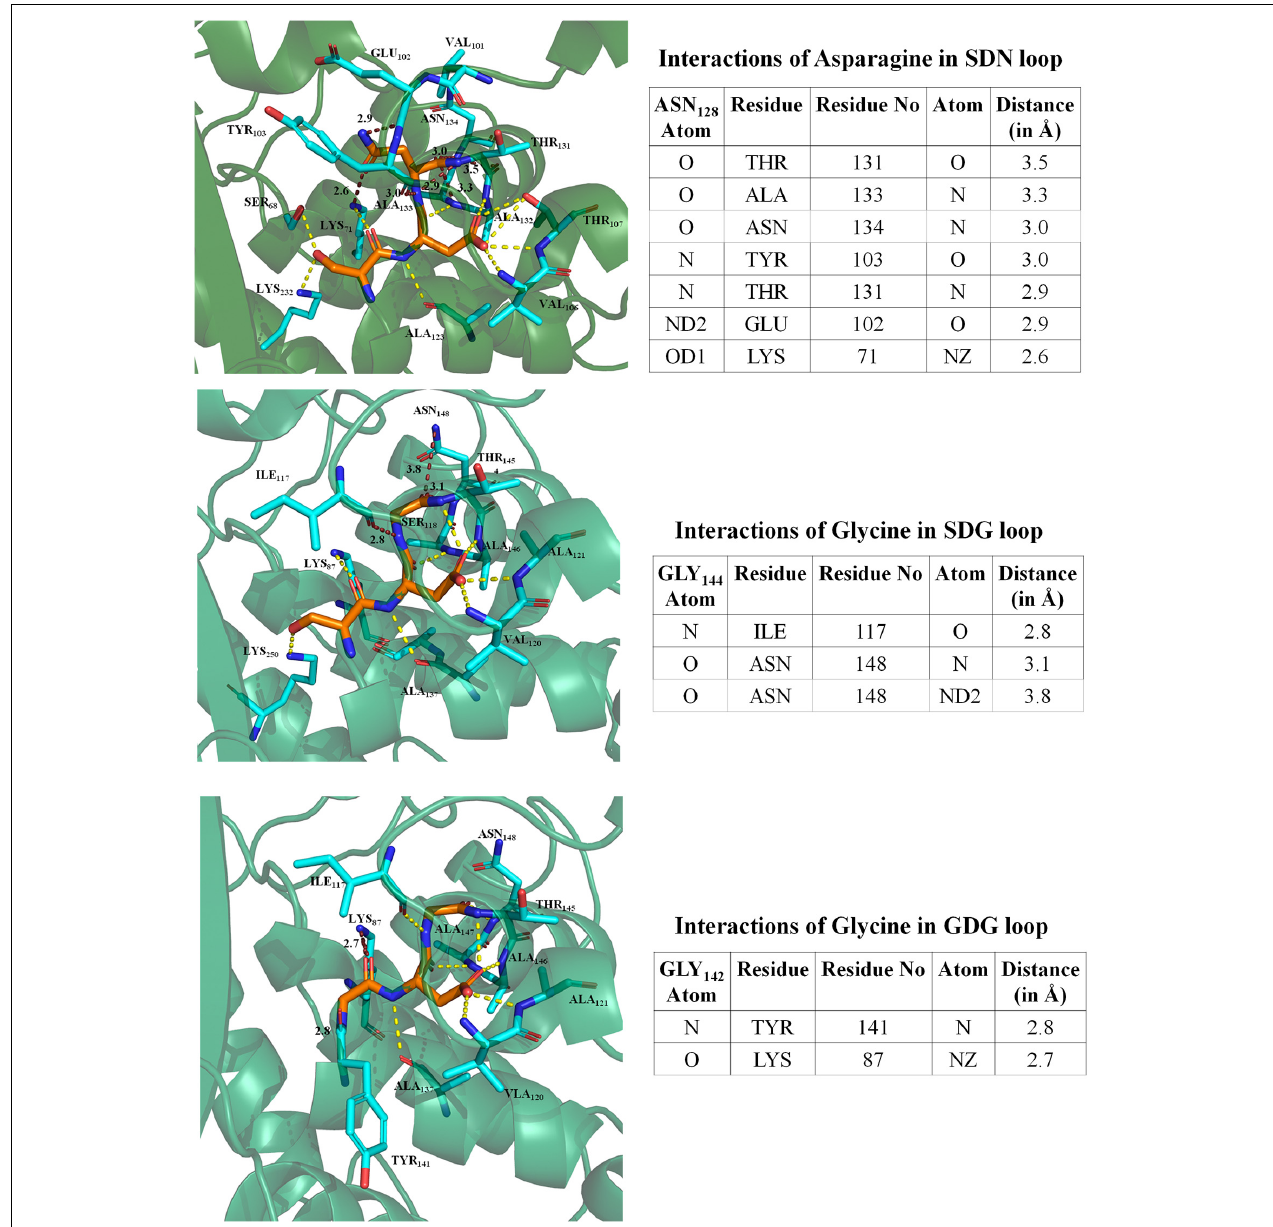
FIGURE 4 | Intramolecular residual interaction network analysis. The top panel describes the residual interaction network of asparagine in the conserve SDN loop of TEM beta-lactamase. The middle panel describes a possible network of glycine in the SDG loop of BlaC beta-lactamase. The bottom panel shows an intramolecular network of GDG mutant in BlaC